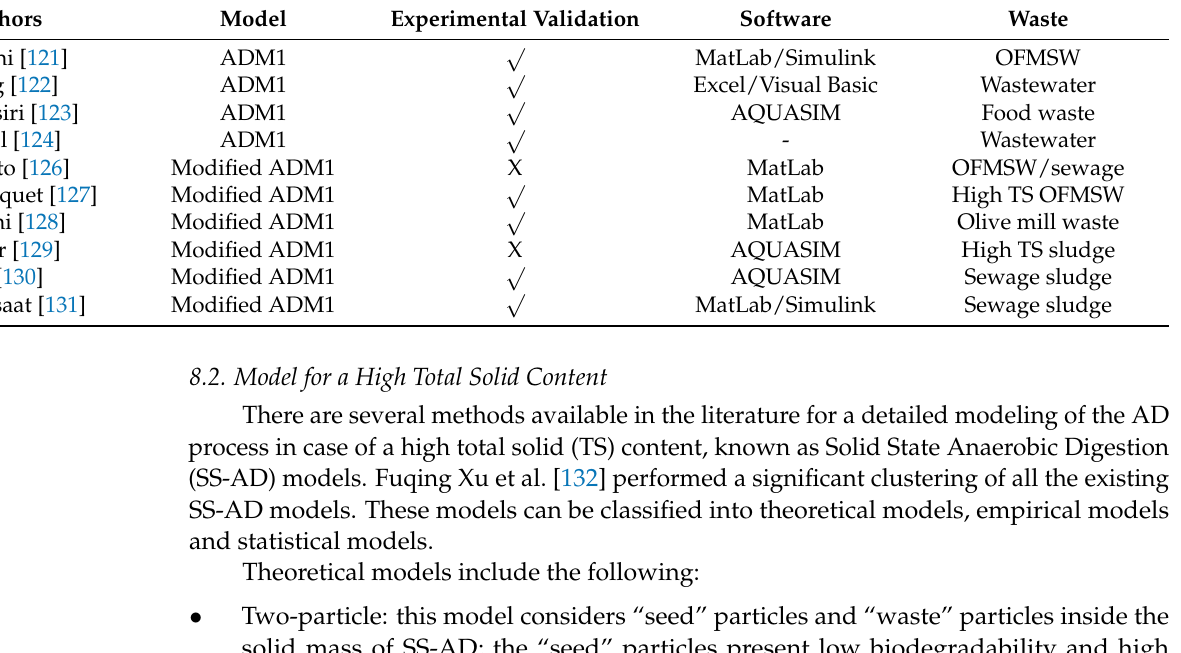
Table 4. Characteristics of AD models available in the